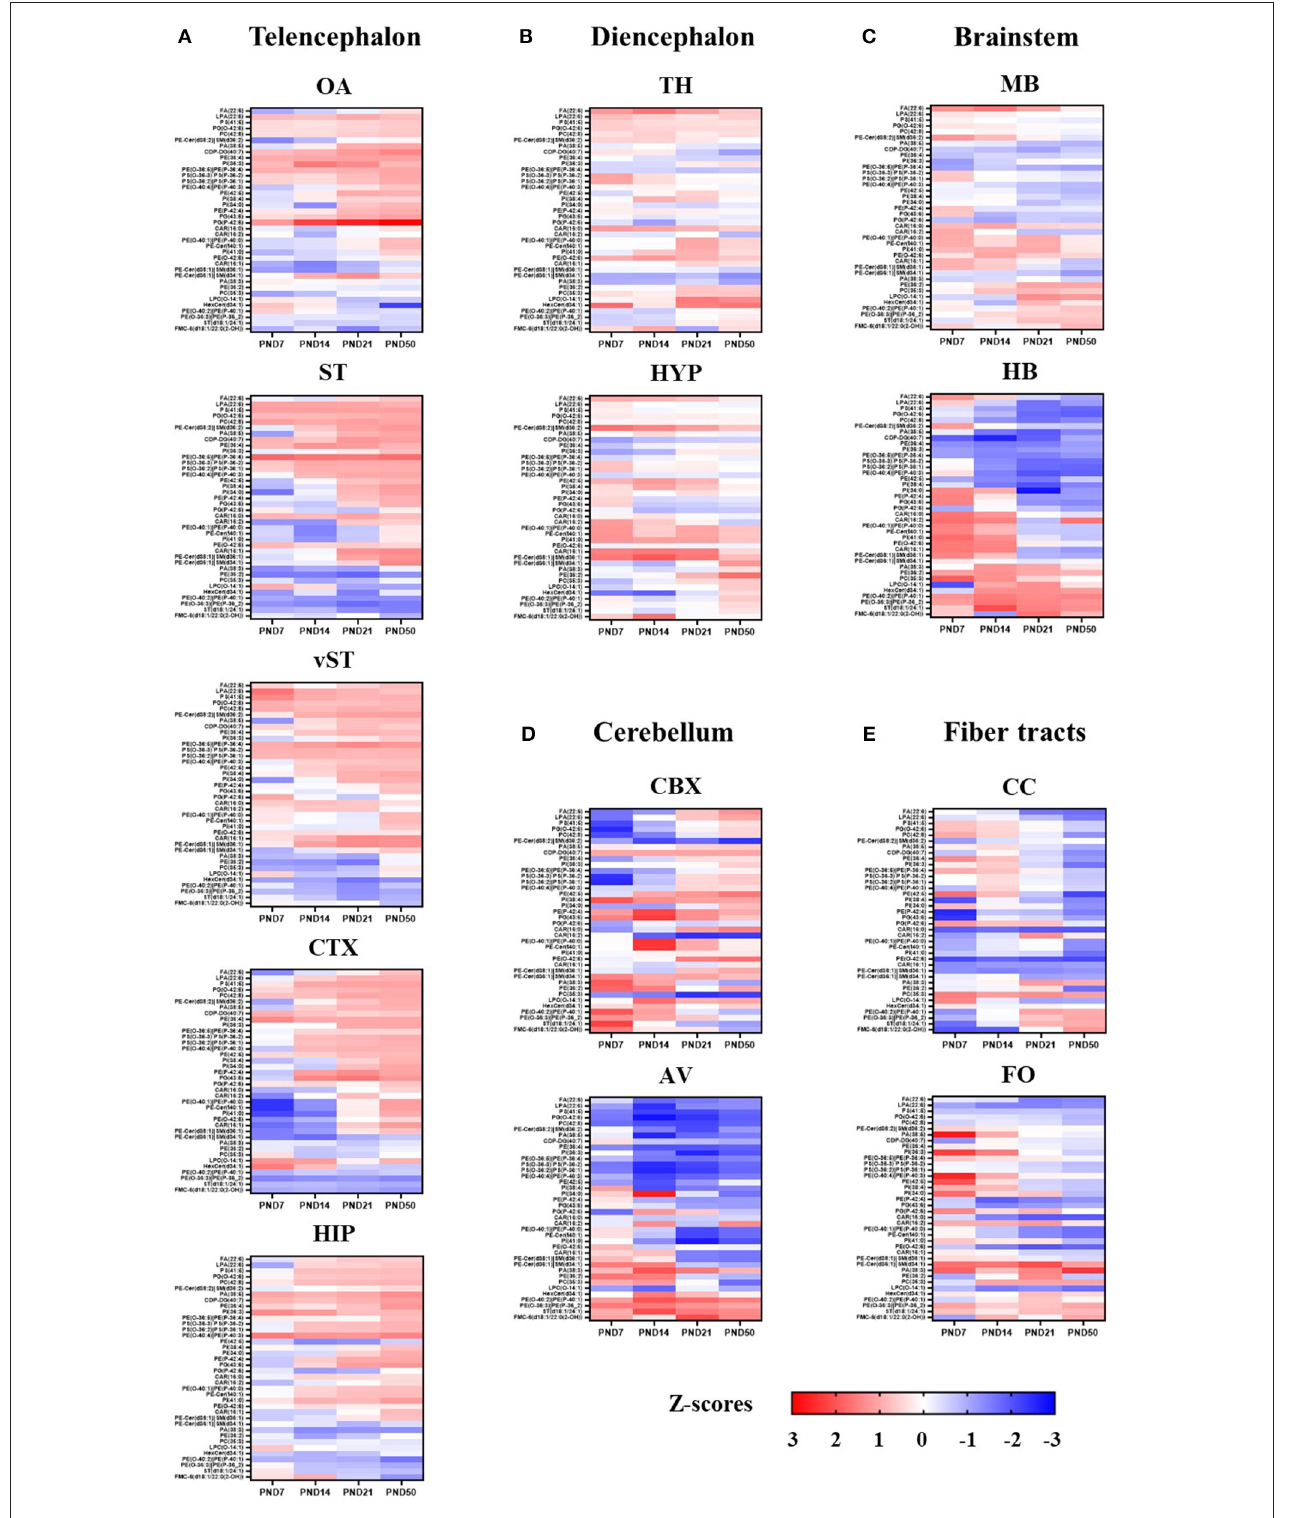
FIGURE 9 | Summary of developmental profile of 39 lipids in each ROI. Developmental profile of 39 lipids in each ROI is represented as a heat map. The scale indicates lowest z-score (-3) in dark blue to highest z-score (3) in dark red. The lipids with coordinated spatio-temporal distribution were clustered together based on the unsupervised pattern recognition analysis using HCA. ROIs are grouped according to the following brain divisions: Telencephalon (A) , Diencephalon (B) , Brain stem (C) , Cerebellum (D) and Fiber Tracts (E) . OA, olfactory area; ST, striatum; vST, ventral striatum; CTX, cortex; HIP, hippocampus; TH, thalamus; HYP, hypothalamus; MB, midbrain; HB, hindbrain; CBX, cerebellum; AV, arbor vitae; CC, corpus callosum; FO, fornix.